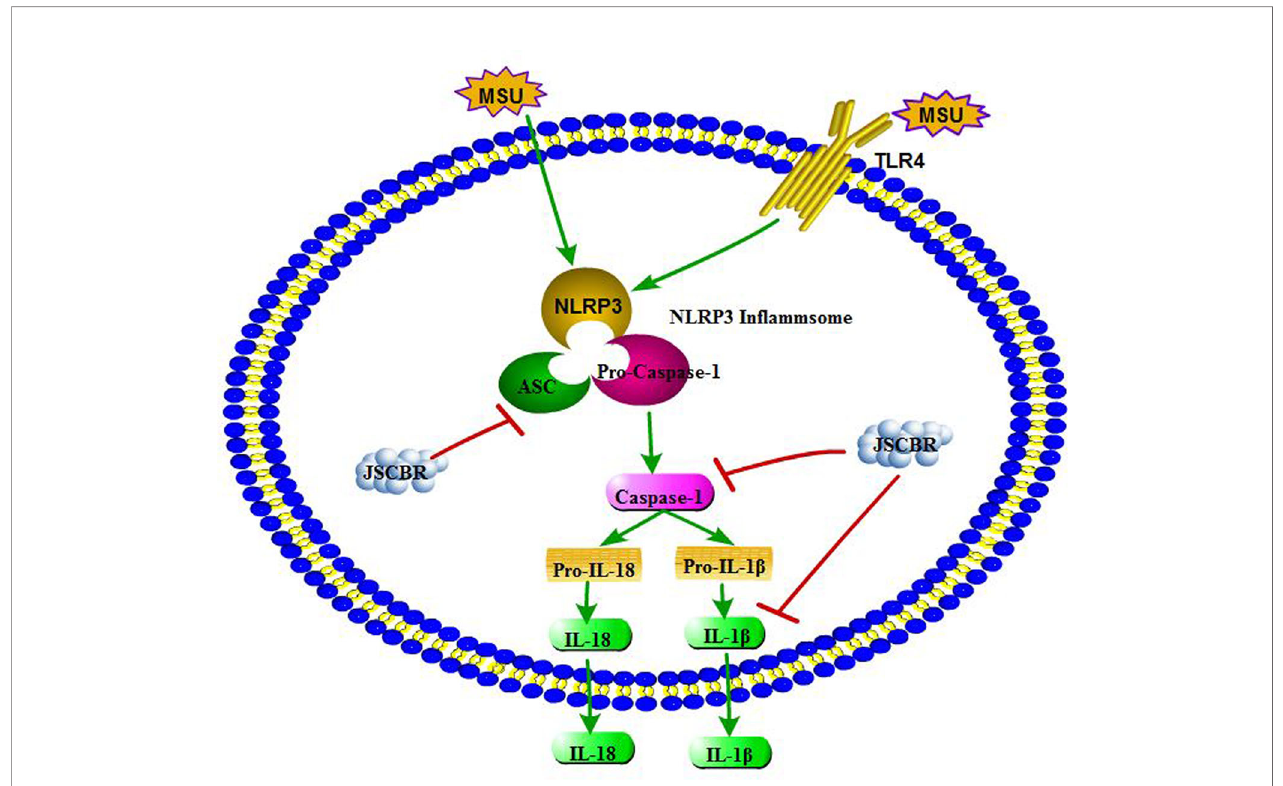
FIGURE 8 | Overview of potential mechanisms underlying the protective effects of Jiang-Suan-Chu-Bi recipe (JSCBR) on monosodium urate (MSU)-induced gouty